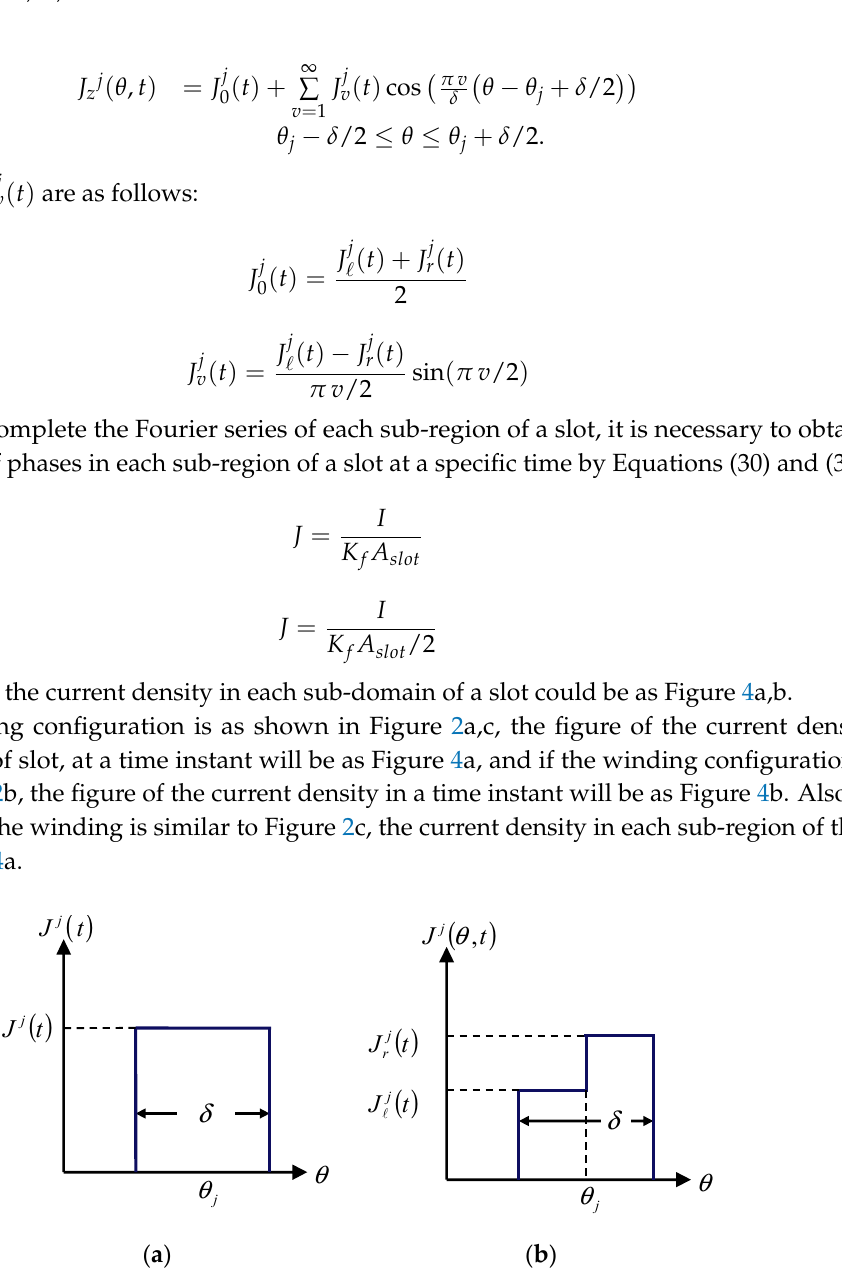
Figure 4. Value of the current density in each sub-region of slot, according to represented winding configurations.